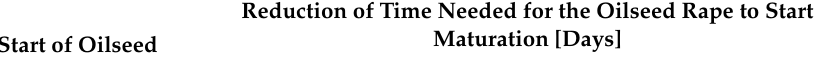
Table 11. The reduction of time needed for the oilseed rape to start maturation predicted for